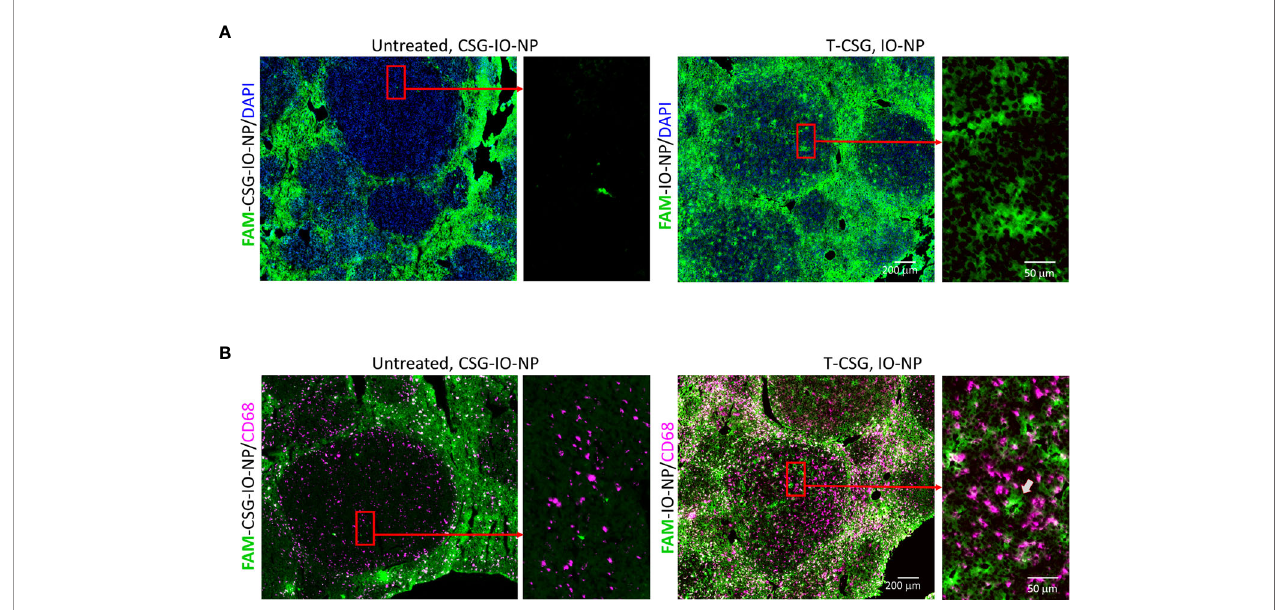
FIGURE 4 | Intratumoral localisation of IO-NP. Liver tissue sections from indicated treatment group 4 h after an i.v. injection of FAM-labelled CSG-IO-NP and IO-NP (as described in Figure 3 ) were analyzed for IO-NP distribution. (A) Representative micrographs show detection of FAM-labelled CSG-IO-NP and IO-NP, which were ampli fi ed by immunostaining with anti-FITC antibody (green). Rectangular box: Selected regions in HCC were compared for IO-NP accumulation at higher magni fi cation. (B) Corresponding tissues in (A) were co-stained for CD68 + cells (in fi ltrating macrophages, red). Arrow: An area within tumor positive for IO-NP that lacks CD68 + cells. Scale bars: 200 and 50 m